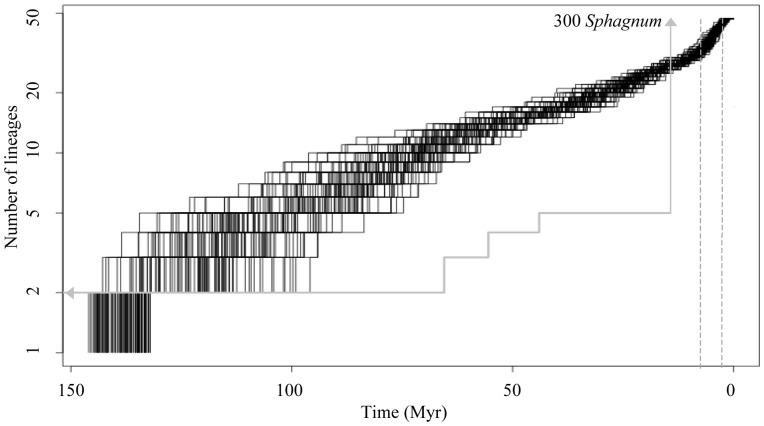
Lineage-Through-Time (LTT) plot of Hyalospheniidae.Lineage-Through-Time (LTT) was plotted using 100 trees of the Hyalospheniidae from the COI dataset analyses. The number of lineages (x axis) is plotted against time (y axis) in such way that each increase on the number of lineages represents a cladogenesis (a node) in one of the 100 phylogetic trees. These 100 trees were randomly taken from Highest Posterior Density (HPD) generated in BEAST from the GMYC dataset. Diversification rate shifts leading to a rate increase (7 Myr ago) and a rate decrease (2.5 Myr ago) as detected in LASER are indicated with dotted grey lines. Grey LTT line is for mosses as extracted from the tree in Shaw and colleagues [16]. The radiation of 300 Sphagnum at 14 Myr ago is indicated with a vertical line and an arrow. Grey arrow on the left indicates the stem age of Sphagnum at 223.8, Shaw and colleagues [16].